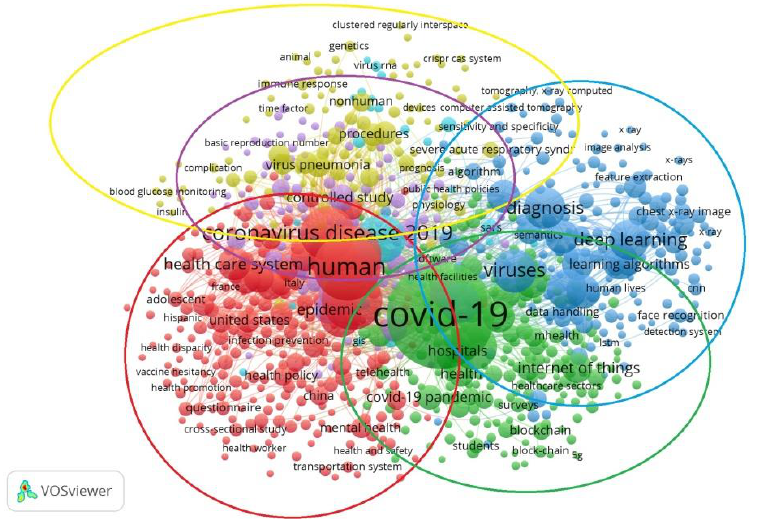
Figure 1. Identification of relationships between the keywords “COVID-19” and “public health system” with other concepts in scientific articles indexed by the Scopus scientometric database. Source: developed by the authors, using Vosviewer.